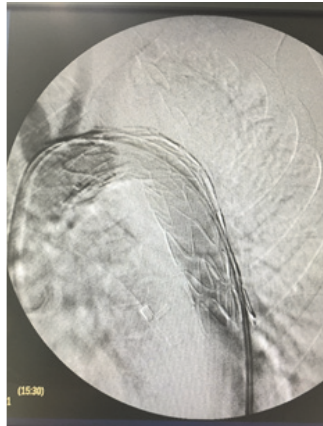
Figure 4: Deployment of Ankura endograft with exclusion of the saccular aneurysm, coverage of the left subclavian artery, and absence of endoleak.